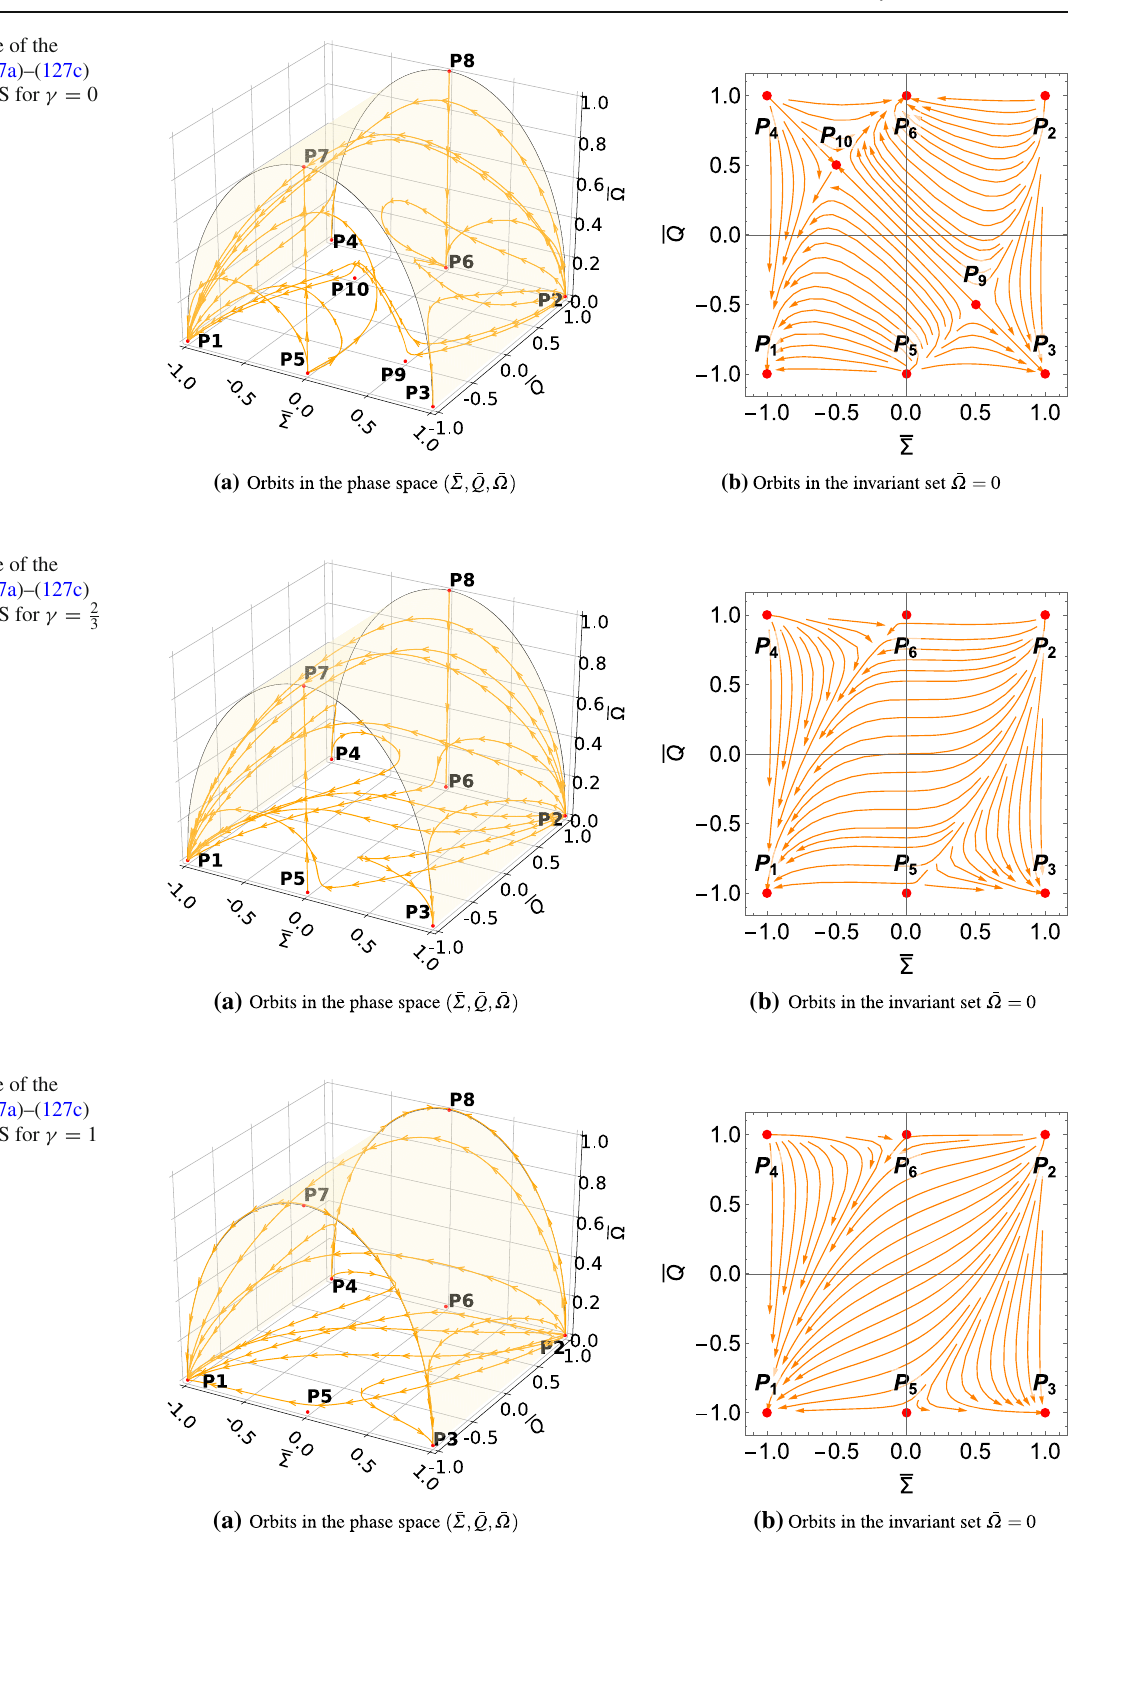
Fig. 2 Phase space of the guiding system (127a)–(127c) corresponding to KS for γ = 0